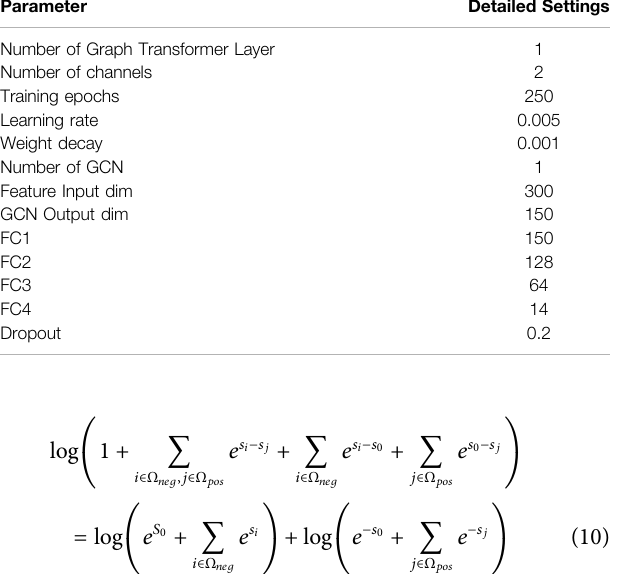
TABLE 3 | DACPGTN model parameter settings. Parameter Detailed Settings Number of Graph Transformer